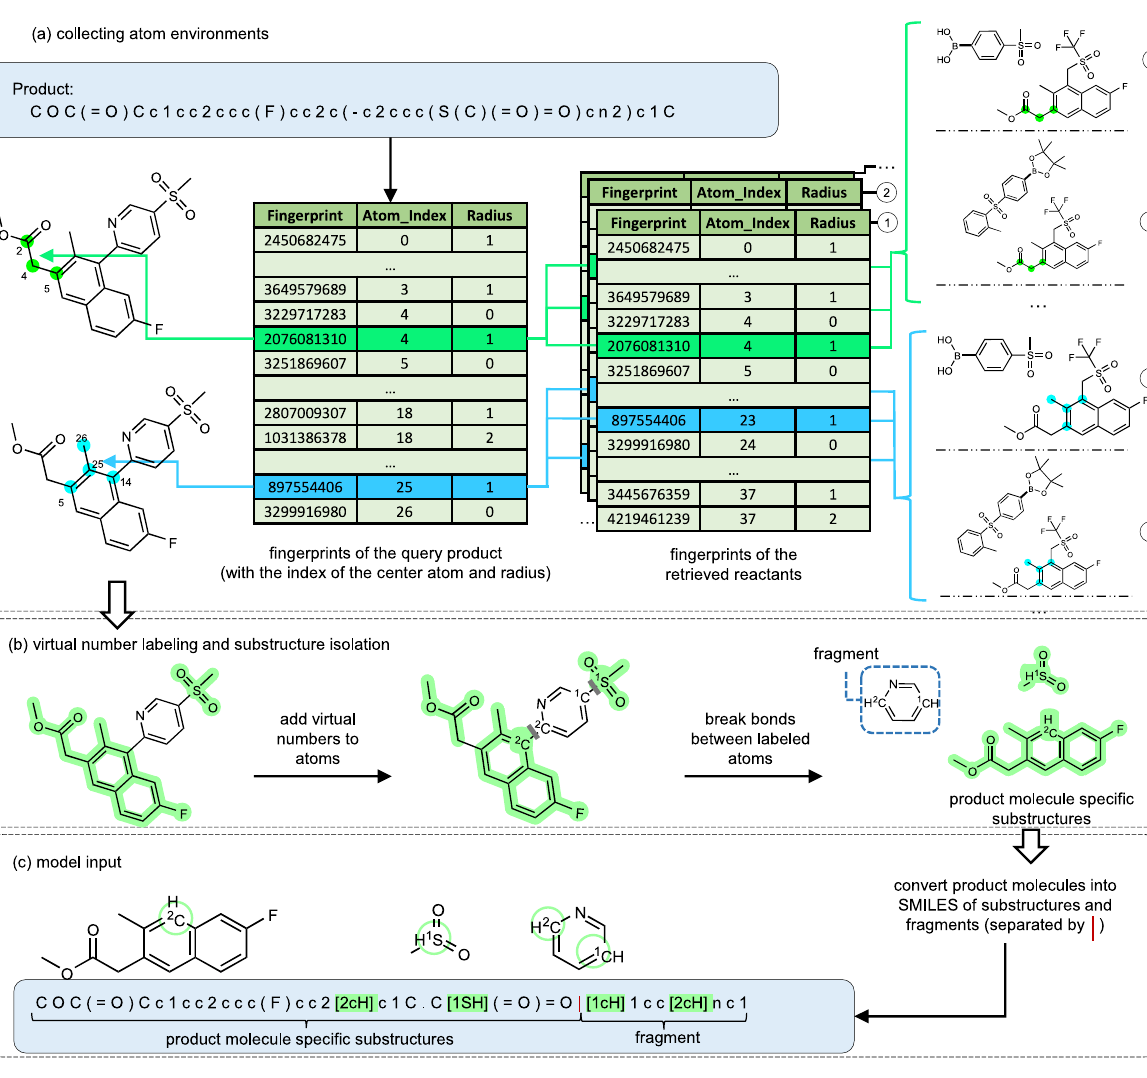
highlighted in green. c Model input, which is the SMILES strings of the sub- structures followed by the SMILES of fragments. The virtually labeled atoms are highlighted in green. “ ∣ ” in the model input is a special character indicating the beginning of product fragments' SMILES